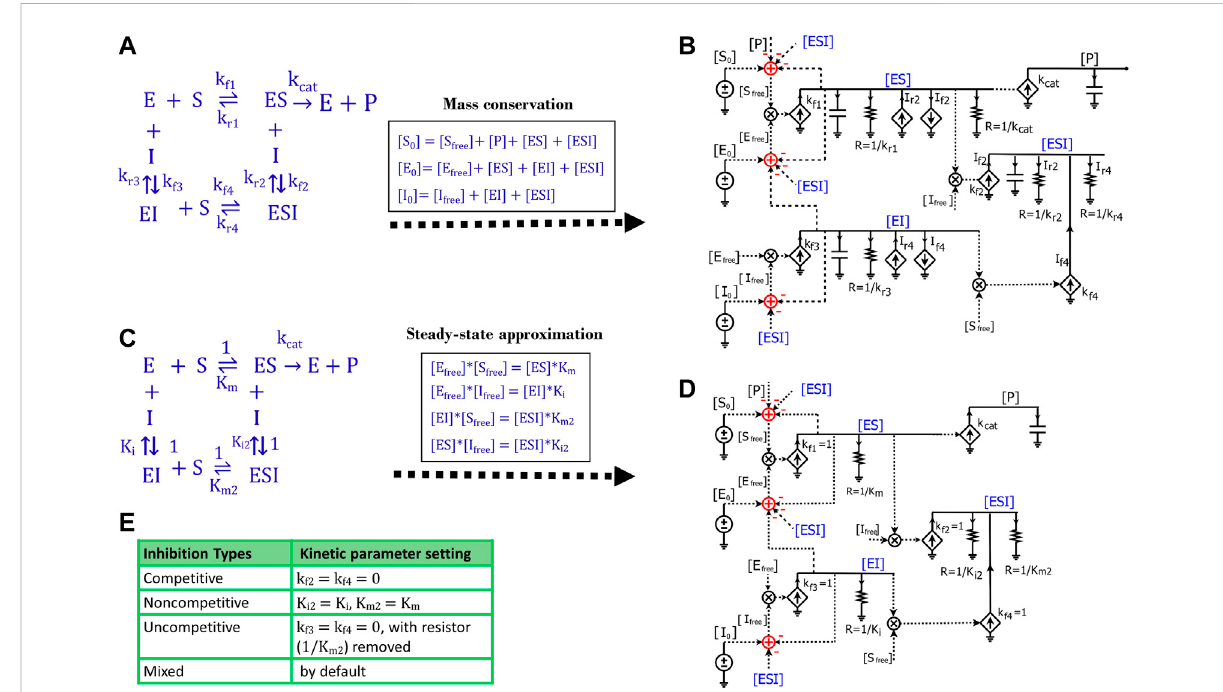
FIGURE 7 Generalizedcircuitmodelsforenzymeinhibition. (A) Areactionschemeofgeneralinhibitionusingrateconstantswithoutanyapproximationor assumption. (B) A circuit model translated from the reaction scheme in (A) describes reaction dynamics. All symbols used in this circuit are the same as the ones used in Figures 1, 3. The dependent current generators (diamond symbols) can provide input source currents (arrow up) or sink currents (arrow down) at nodes that they are wired to. Voltages or currents labeled with same names indicate that they have the same values: in accord withthereaction,thesamecurrentorvoltageisappropriatelyre-usedorregeneratedatmultiplelocationswiththeuseofimplicitratherthanexplicit wiring to avoid clutter. (C) The reaction scheme of general inhibition in (A) , but with a steady-state approximation (all complexes reach equilibria instantaneously). Here, normalized k f parameters are set to 1, such that all k r parameters are mapped to their corresponding equilibria dissociation- constant (K m or K i ) values. (D) The generalized circuit for enzyme inhibition translated from the reaction scheme in (C) . Note that, in accord with the steady-state approximation, the capacitors in (B) are removed in (D) ; and kinetic parameters in the reaction scheme (C) are mapped to equivalent circuit parameters in (D) . The latter circuit can simulate all common enzyme-inhibition mechanisms including competitive, noncompetitive, uncompetitive, and mixed inhibition. (E) Kinetic parameter settings for different types of enzyme